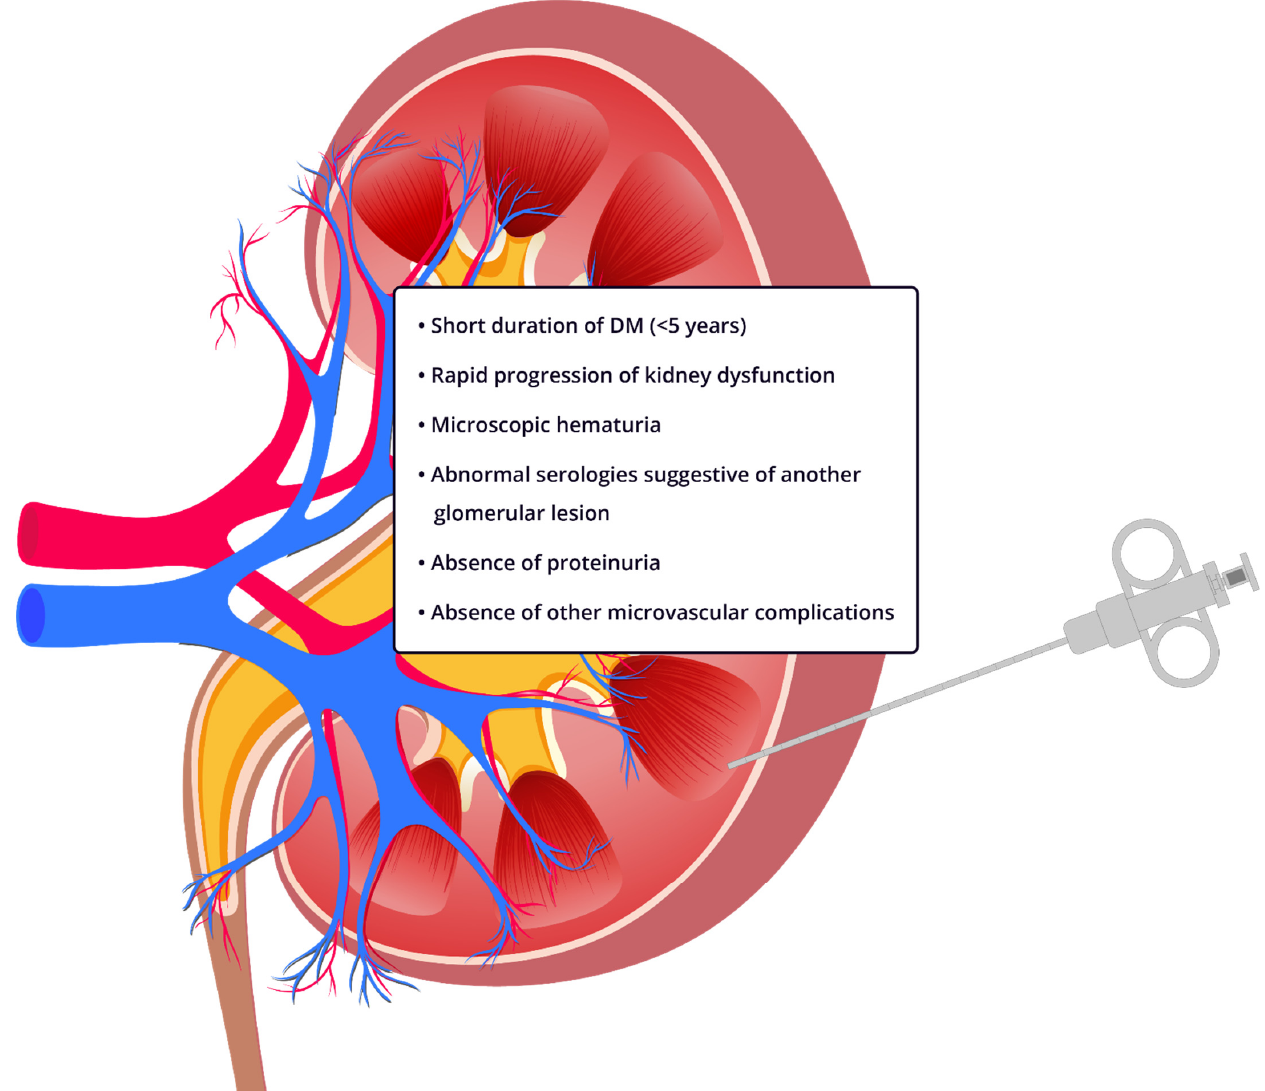
Figure 2. Indications for kidney biopsy in patients with diabetes and suspected nondiabetic kidney disease. One or more of the following criteria should raise suspicion of NDKD and prompt a kidney biopsy in diabetic patients.